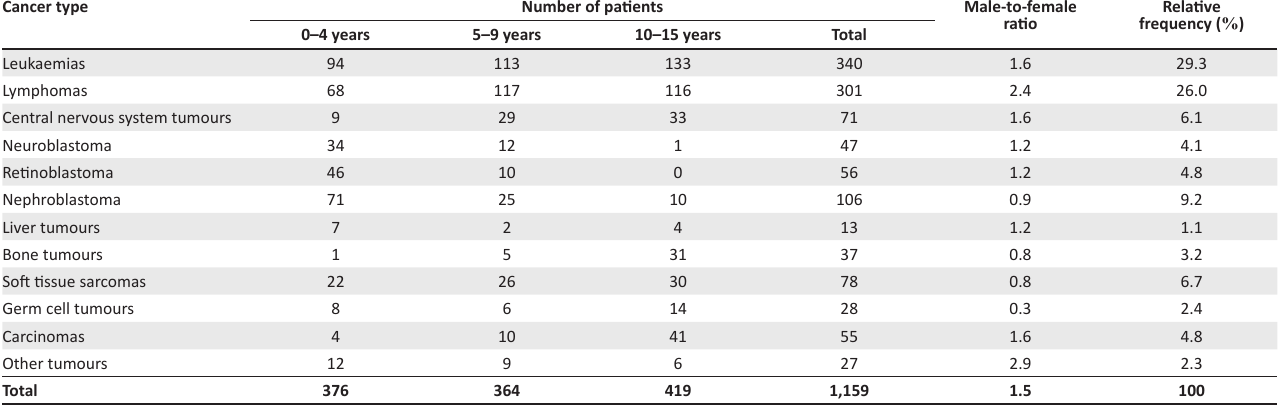
TABLE 1: Distribution of childhood cancers according to patient age, sex and relative frequency ( n = 1159). Cancer type